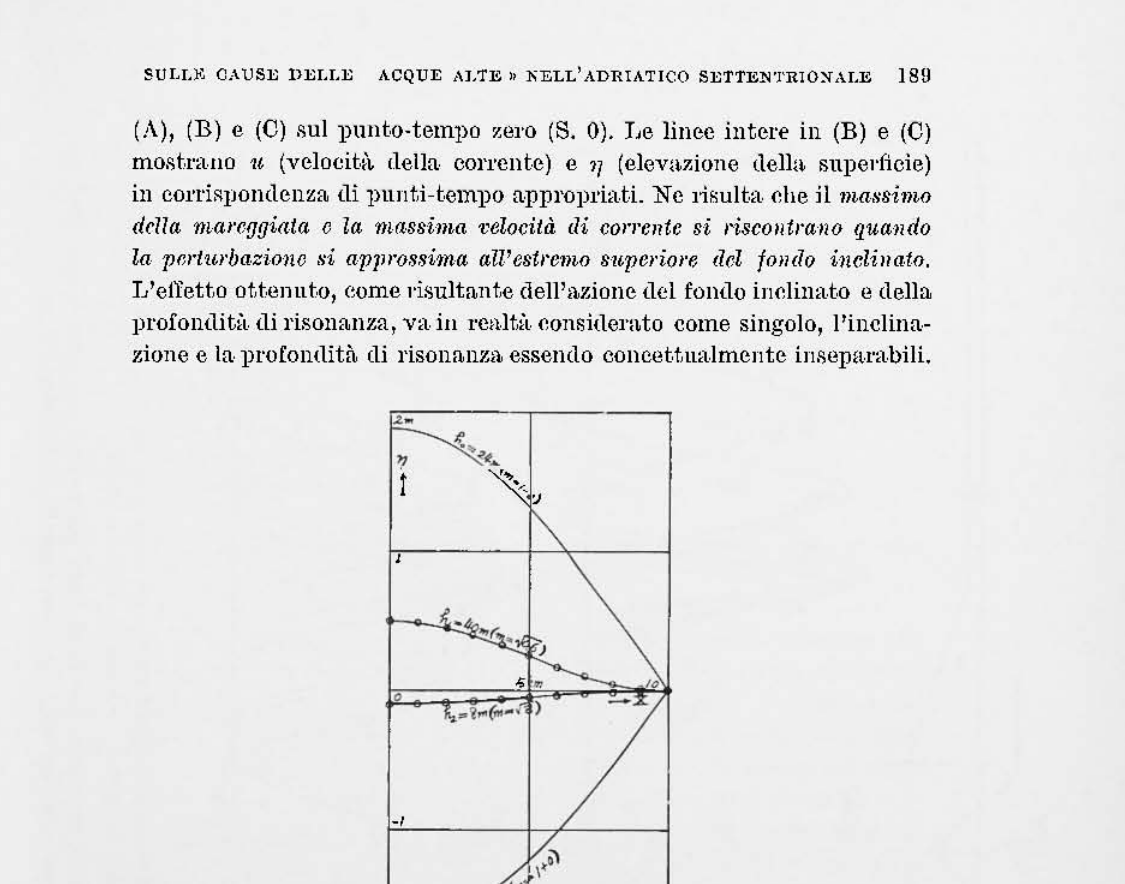
Fig. II _ Di8tl'ilmzione degli inlln.lzamenti di livello nl'i caso contemplato in (27] - SeeoIlllo Yamada cd al. Fig. Il - Distrilmt.ion of level misings in the case eon8iùereù unùer [27] - After Yamada anù